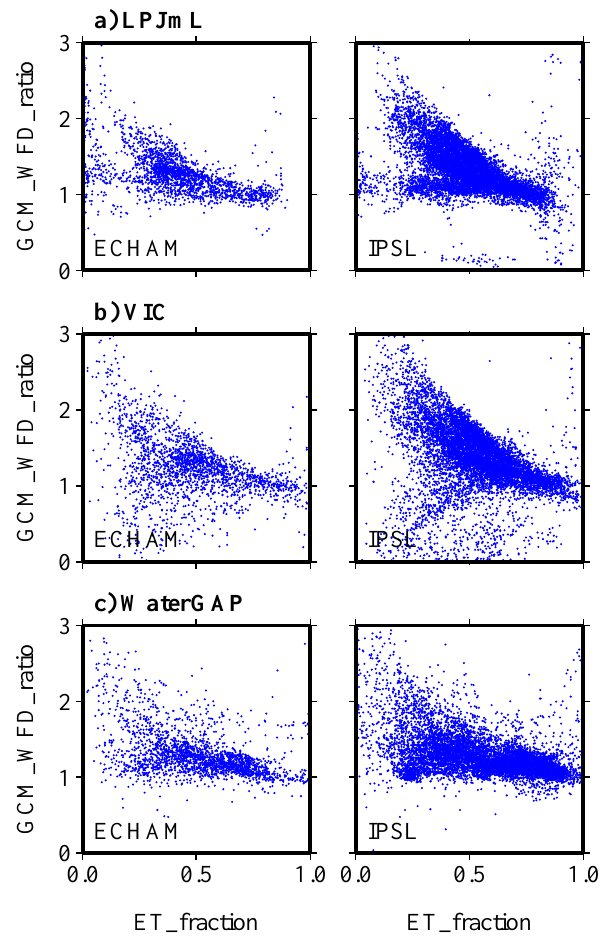
Figure 7: WDD evapotranspiration fraction divided by WFD evapotranspiration fraction (y-axis) plotted against the WFD evapotranspiration fraction (original results, control period, ECHAM to the left, IPSL to the right). Only cells where the climate model total radiation is more than 10 percent higher than the WFD total radiation are included.